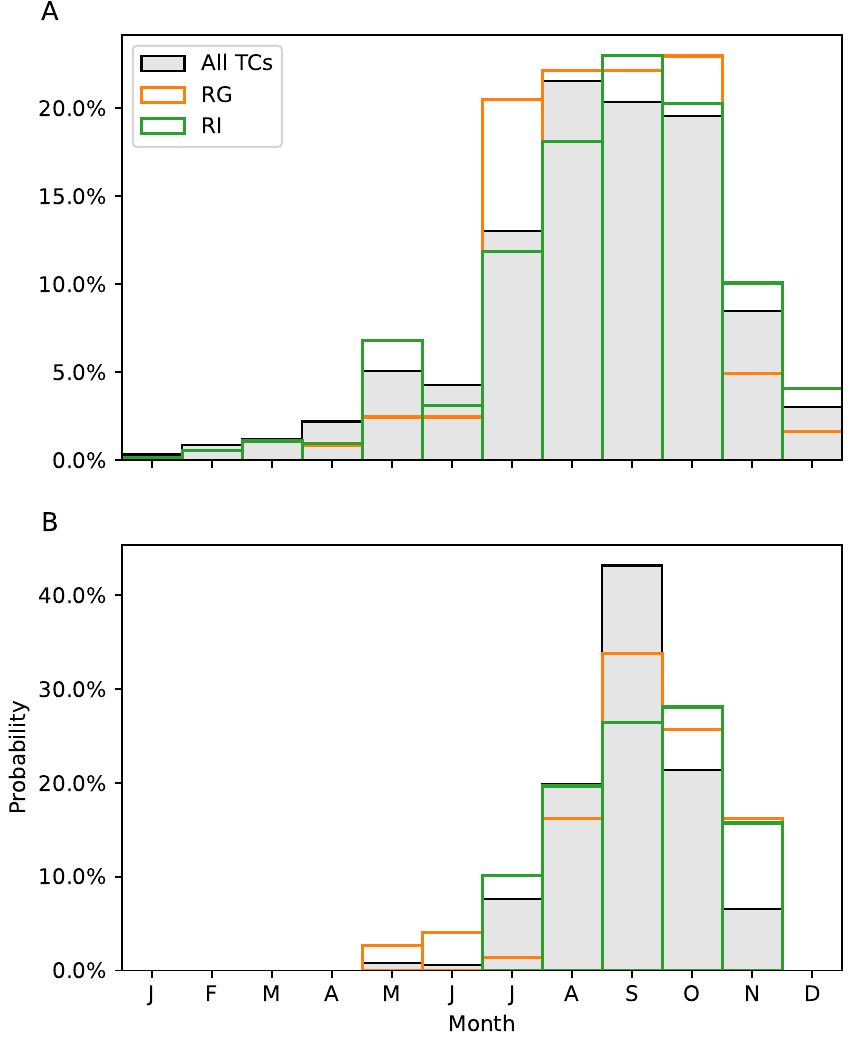
Figure 8. Temporal distribution of rapid growth (orange) and rapid intensification (green) events for the ( A ) western north Pacific and ( B ) north Atlantic